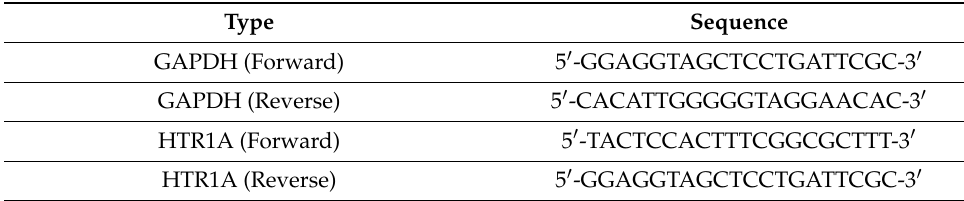
Table 1. PCR primer sequences for PCR